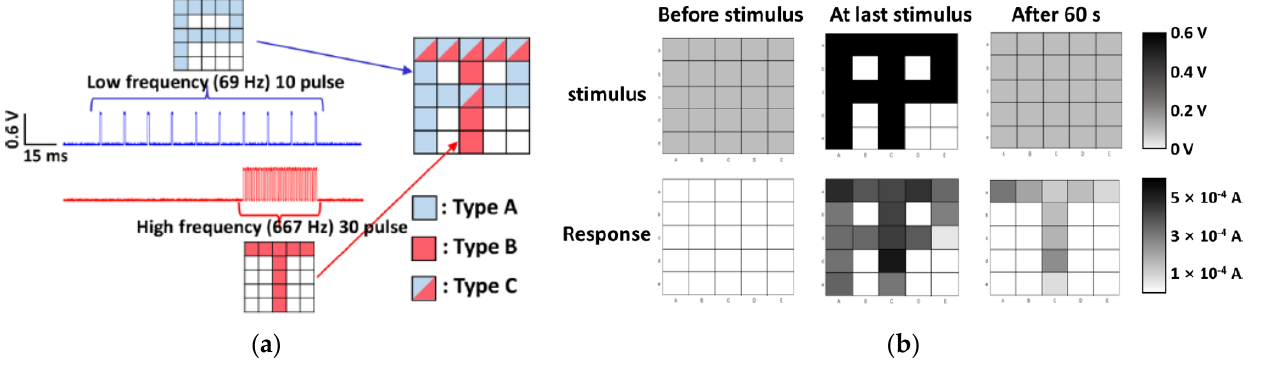
Figure 6. STM and LTM demonstrated by pattern memorization of a l-car artificial synapse 5 × 5 array [27] when two sets of stimuli with different pulse number and frequency were applied. ( a ) Letters of ‘P’ and ‘T’ are memorized on a 5 × 5 l-car memristor array by inputting the letter of ‘P’ for 10 times at a low frequency and ‘T’ for 30 times at a high frequency, respectively. ( b ) Applied stimulus and current response of the l-car memristor array before stimulus, at the last stimulus, and after 60 s.